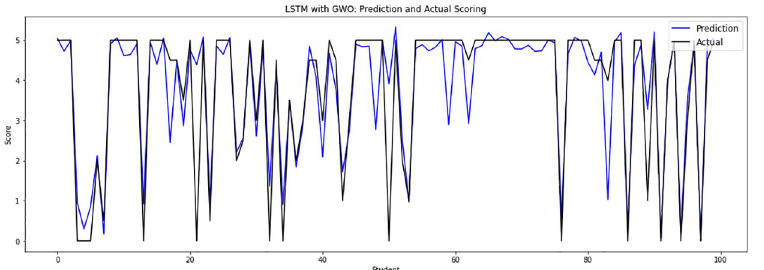
Fig 6. LSTM-GWO prediction and actual scores with experiment 1.